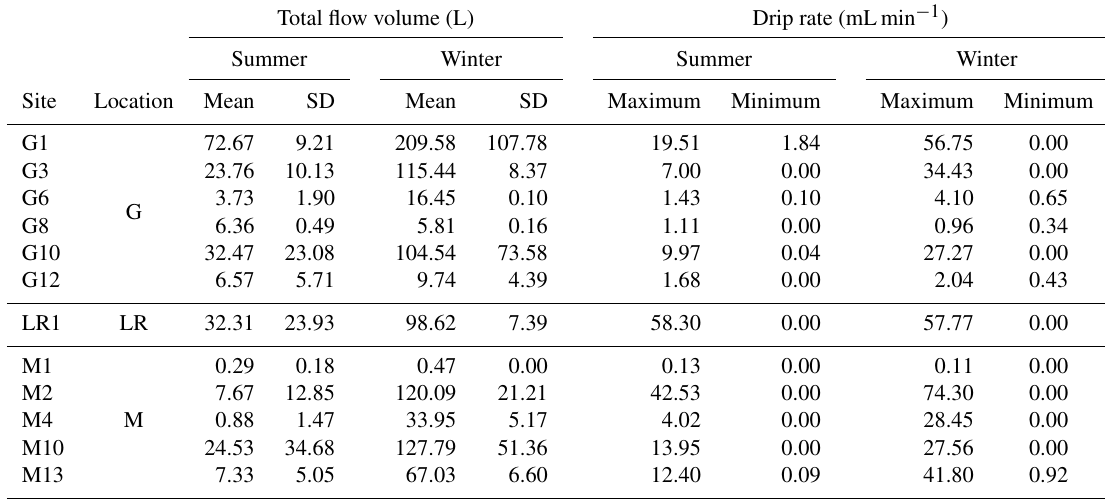
Table 1. Summary of drip sites and location within cave as indicated in Fig. 1, the monthly mean and standard deviation (std) of total flow volume and maximum and minimum drip rate in summer (December–February) and winter